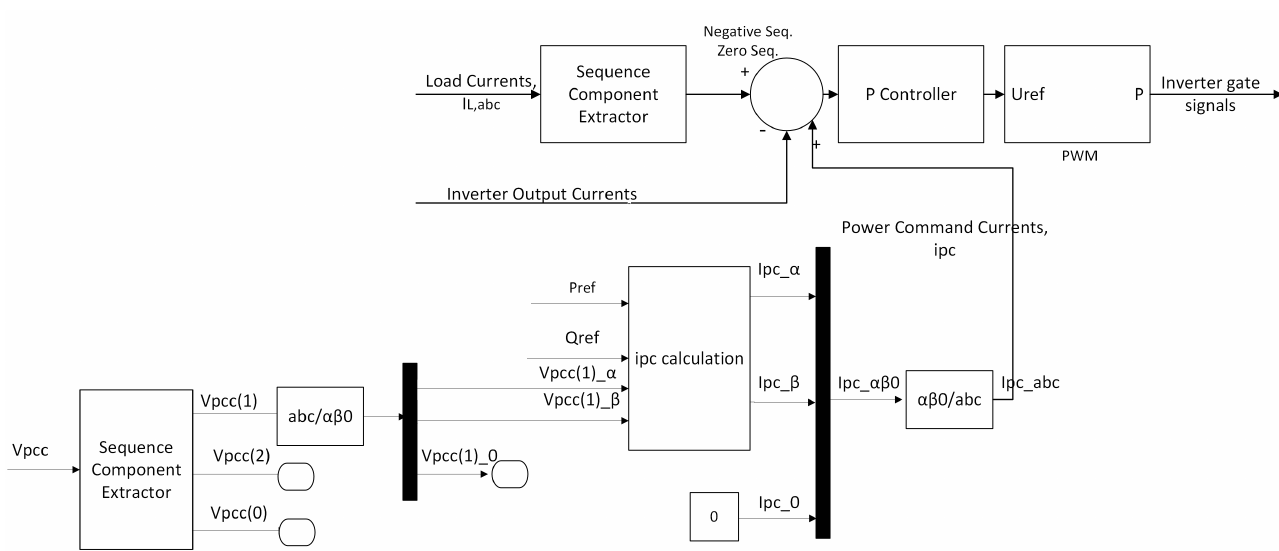
Figure 6. Completed block diagram of the proposed methodology bidirectional power control under unbalanced grid conditions.